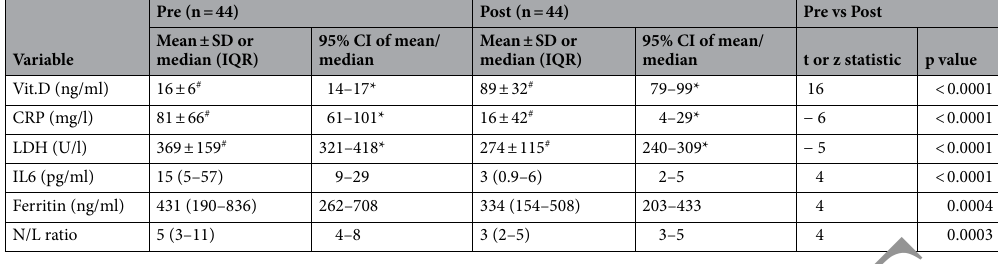
Table 1. Values of various parameters studied in the VD group before and after treatment. Vit.D Vitamin D, CRP C-reactive protein, LDH Lactate dehydrogenase, Il-6 Interleukin-6, N/L ratio Neutrophil/Lymphocyte ratio, IQR Interquartile range, # mean ± SD, * 95% CI of mean.